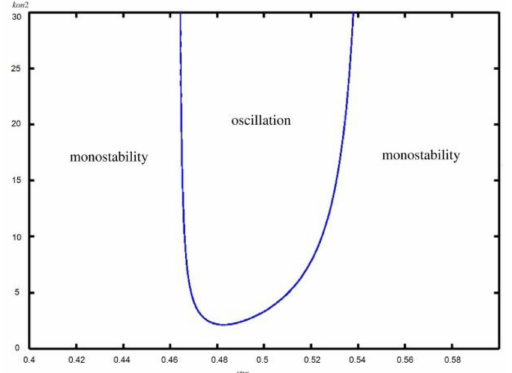
Figure 4. The bifurcation diagram of the k on2 versus ATM* concentration.